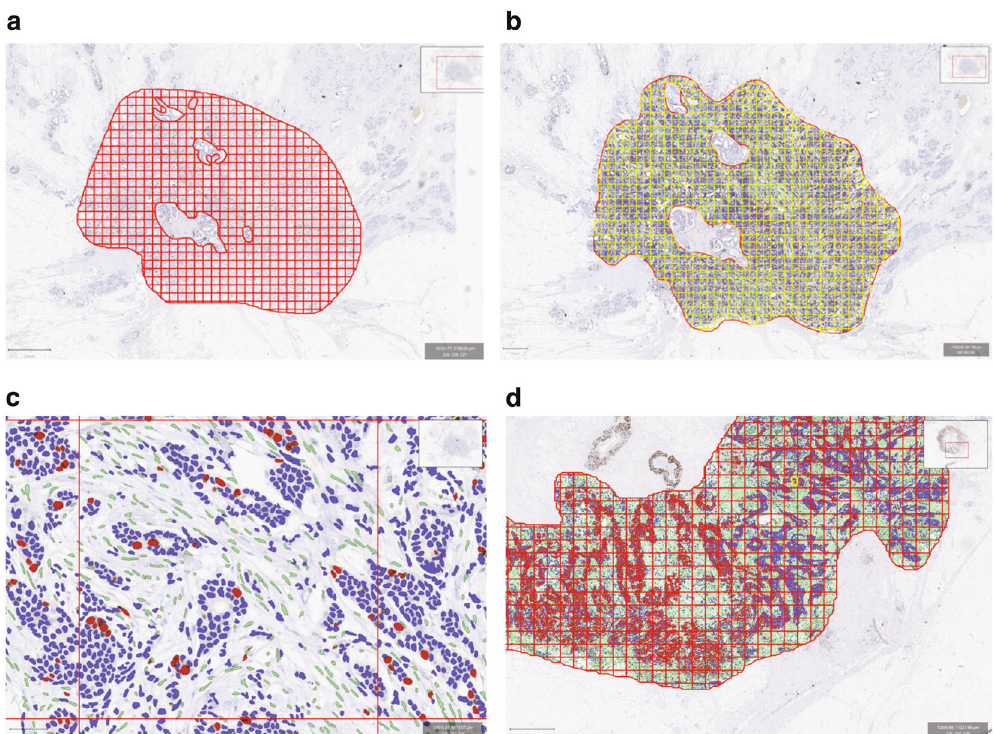
Fig. 4 Schema of QuPath image analysis steps. a After entire invasive tumor area is identi fi ed as a region of interest using a hand drawing tool, 300 × 300 μ m grids were generated to fi ll the region of interest. b After positive cell detection within each grid, cell classi fi er is generated based on annotation of representative tumor and host cells, and applied to all grids. c Magni fi ed view of a single grid after cell classi fi er is applied (right); negative tumor cell nuclei (blue), positive tumor nuclei (red), stromal cell nuclei (green). d An example of within-tumor heterogeneity of ki67 staining with left side showing nearly 100% cells staining while right side show lesser